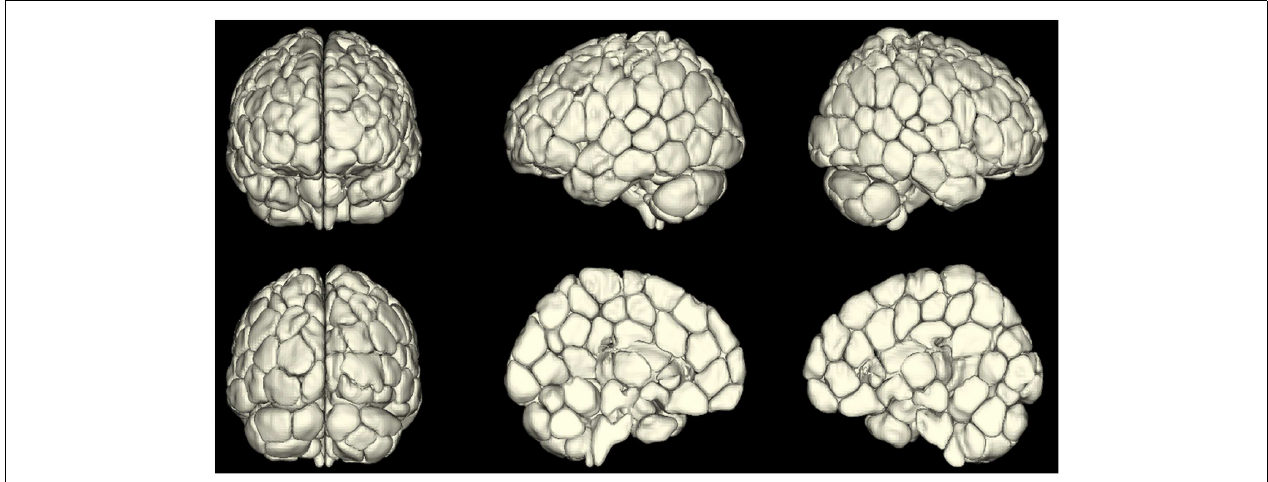
time-courses for each voxel within a given node by definition.This parcelation approach (Shen et al., 2010, 2013) provides a solution to the ROI definition problem in connectivity or network analysis of the